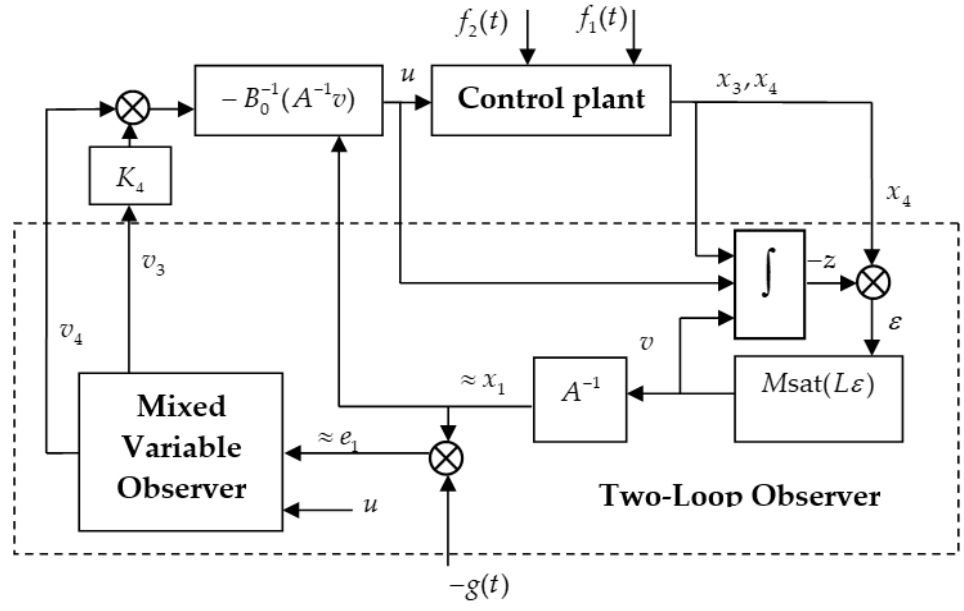
Figure 2. Block diagram of a closed-loop system (1), (2), (39).